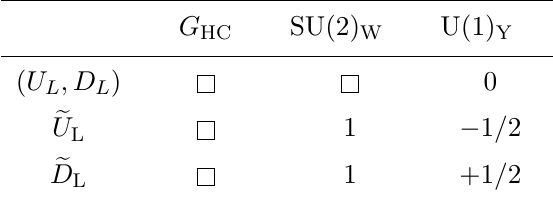
Table 1 . The new fermion content and their representations under the gauge